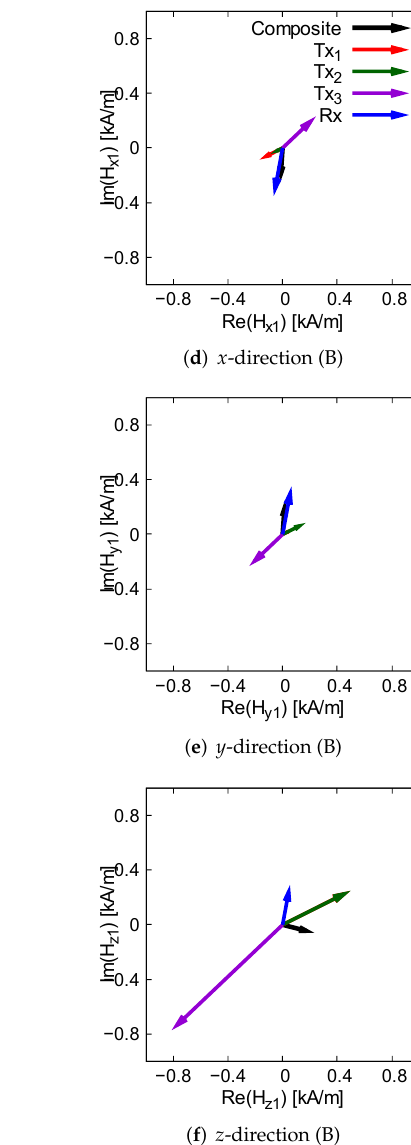
Figure 13. Phasor representation of the magnetic field in each direction ( α = 0.9, three Tx coils, k = 1): ( a – c ) magnetic field at A; ( d – f ) magnetic field at B. The phasor display of the magnetic field in each direction with five Tx coils is shown in Figure 14. The composite vector in each direction became almost zero at not only A, where the magnetic field suppression effect was high with three Tx coils, but also at B, where the magnetic field suppression effect was insufficient with three Tx